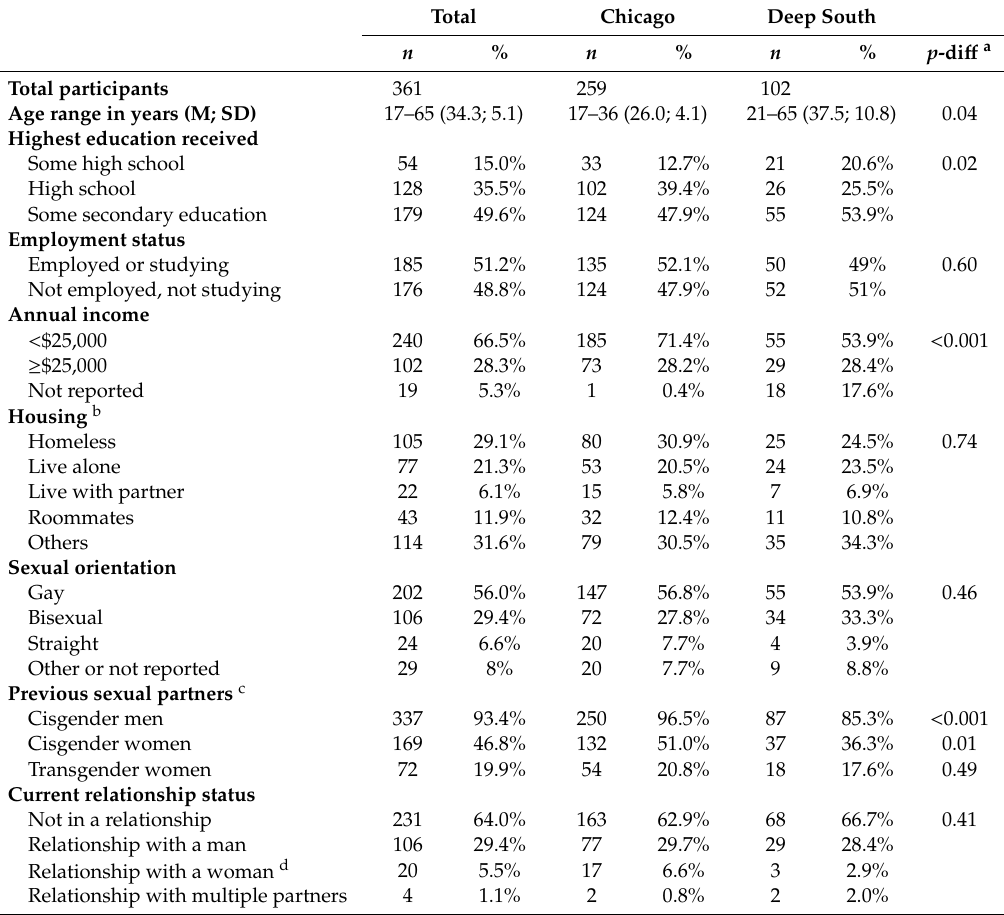
a Di ff erences assessed using Chi-squared (categorical) or ANOVA (continuous); b In the previous 12 months; c Non-exclusive categories; d Includes cisgender and transgender women. Table 3 provides an overview of HIV and sexual health practices data, including self-reported baseline HIV prevalence. Overall, 123 men (34.1%) self-reported as HIV positive at enrollment, which did not di ff er between Chicago and the Deep South. However, among men with HIV, while treatment uptake was similar between sites, in a univariate analysis, we identified higher levels of self-reported ART adherence among men in the Deep South than in Chicago (63.3% versus 49.4% ‘always or almost always’ adherent, p = 0.03). Consistent condom use for anal or vaginal sex was low among our sample but similar between sites, with 22.9% of men in Chicago and 28.9% in the Deep South reporting always using a condom ( p = 0.26). Participants from the Deep South were much more likely than those in Chicago to report having previously paid for sex (i.e., as a sex work client; 18.6% versus 3.9%, p < 0.001) but at the univariate level, there was no di ff erence in the proportion who reported being paid for sex (16.9% of the overall sample were paid for sex or received some other compensation at least once in the 12 months prior to